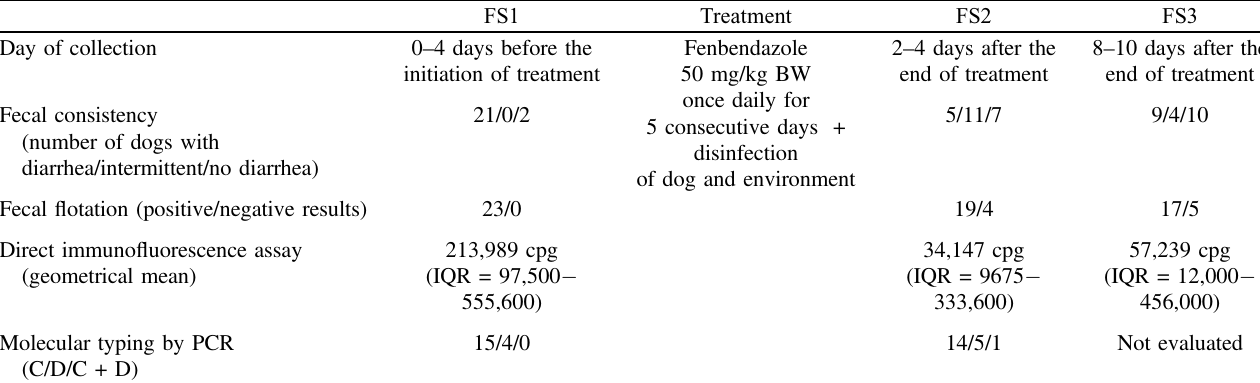
Table 1. Study design and fecal examination methods for all the time-points of fecal collection in 23